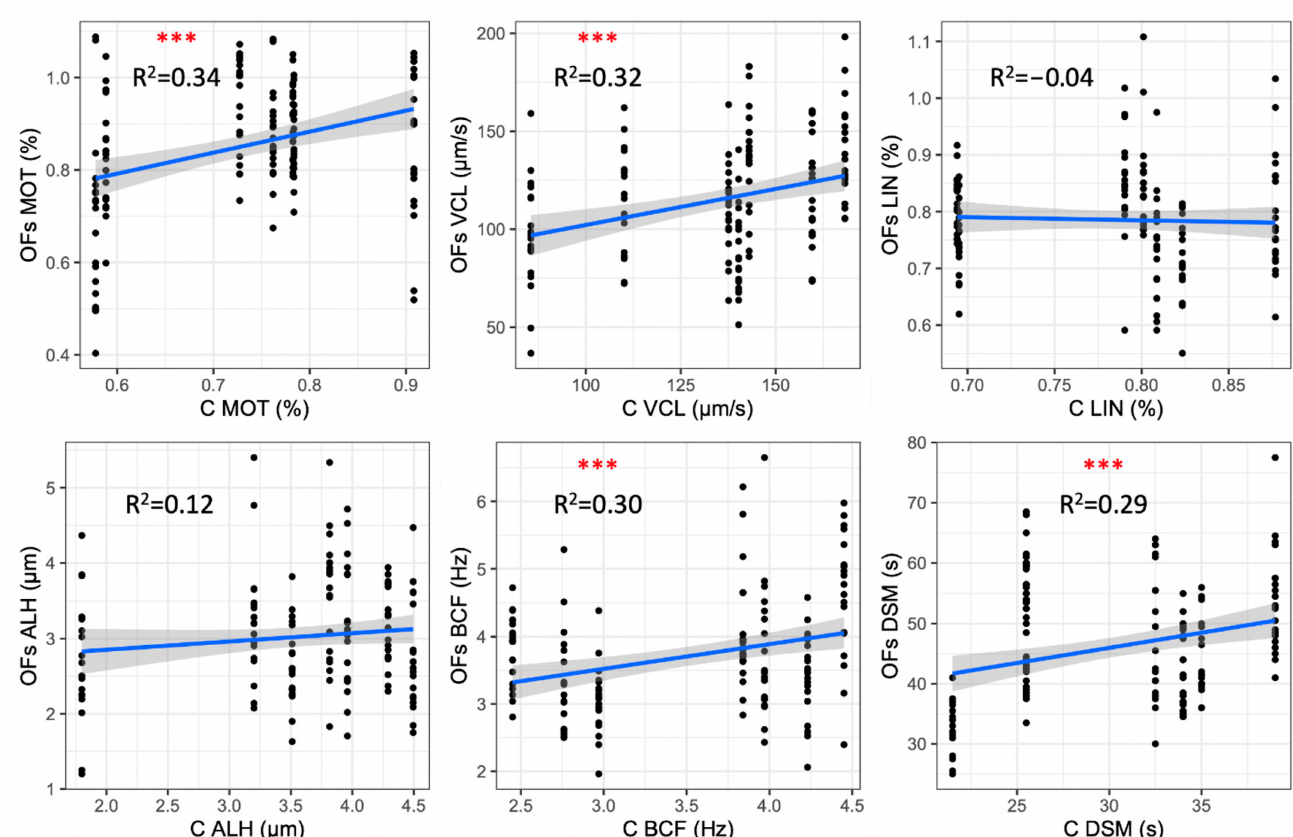
Figure 2. Correlation among the post-thaw sperm motility parameters using ovarian fluid and control activation solution. Significance levels (in red) and coefficients of determination (R 2 ) are